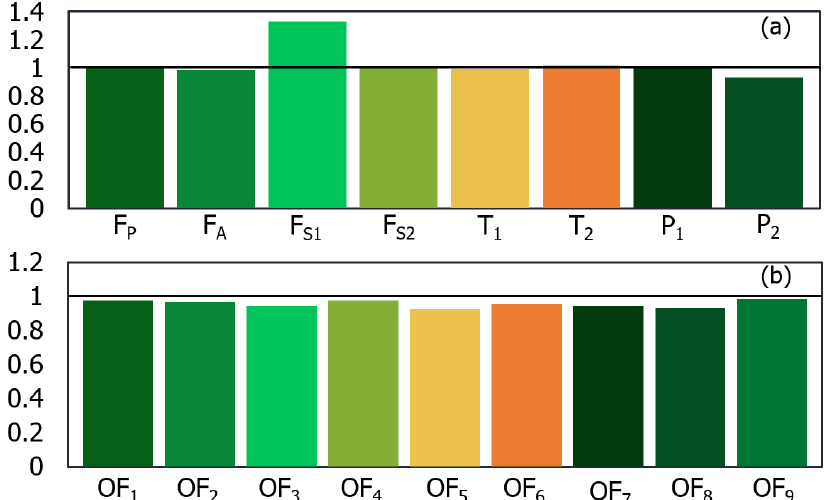
Figure 9. Best ranked solution for ( a ) decision variables and ( b ) objective functions using NFM with ANN, normalized with respect to the best solution of the phenomenological model.